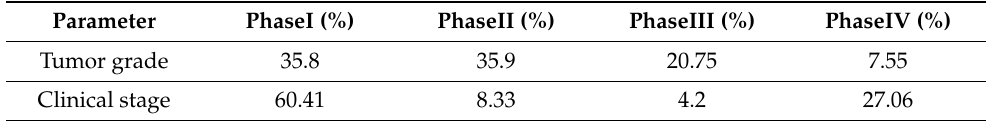
Table 3. Distribution of histological grade (A) and disease stage (B) in HCC patients.